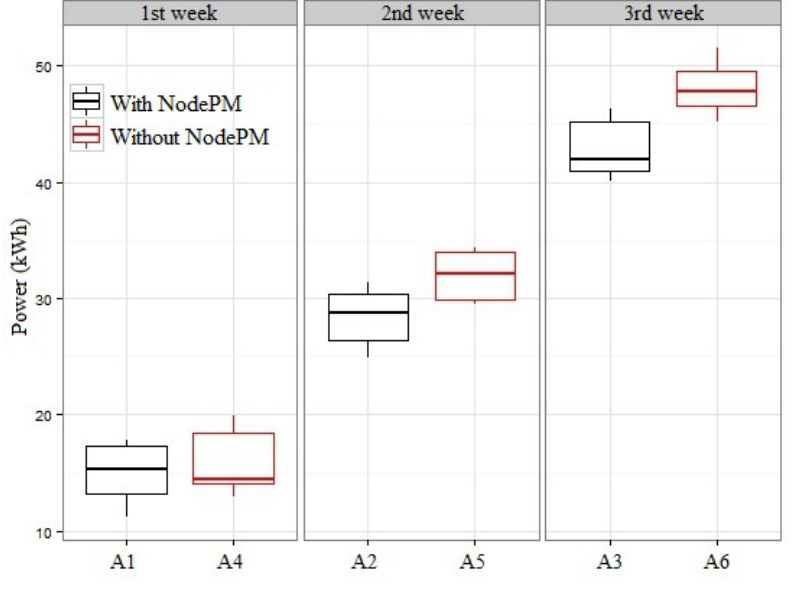
Figure 9. Analysis of the performance of NodePM in accordance with Table